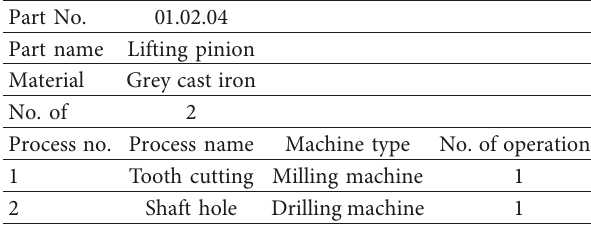
Table 7: Slider gates.